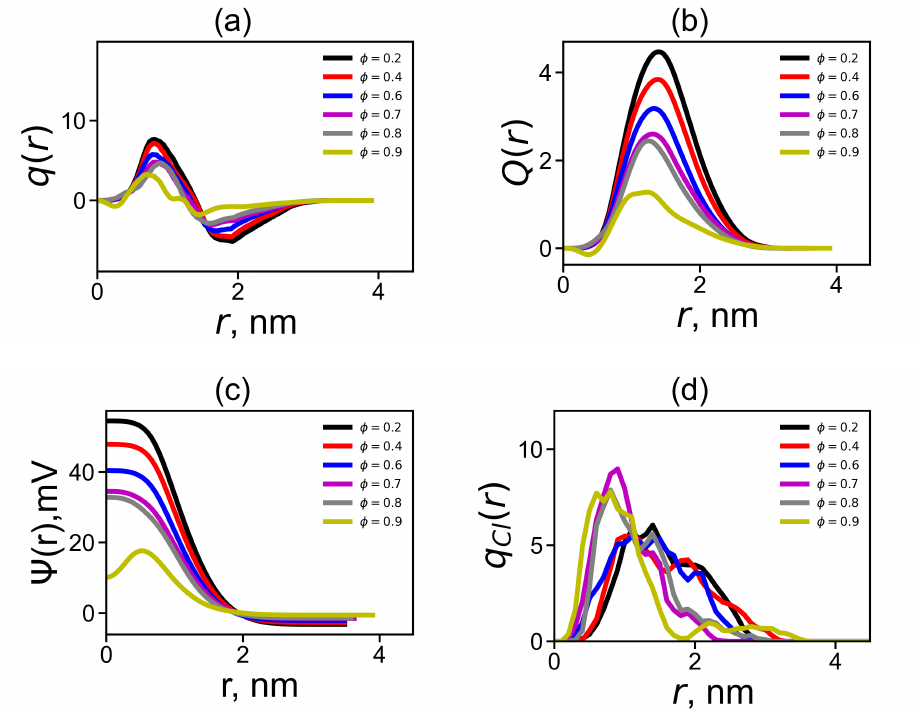
Figure 7. The radial distribution for DGL1 of ( a ) the total charge q ( r ) , ( b ) the cumulative charge Q ( r ) , ( c ) the electrostatic potential Ψ ( r ) , and ( d ) the distribution q Cl ( r ) of the counterion